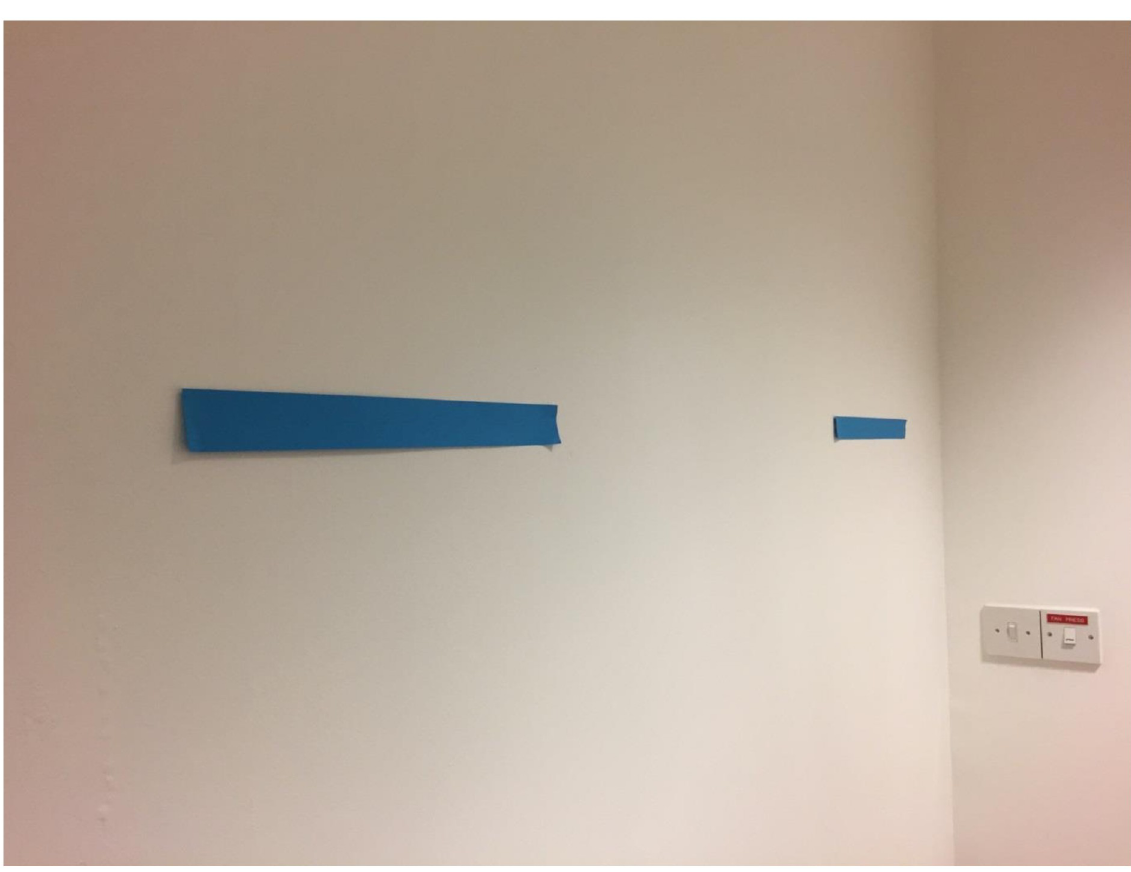
Fig 1. A photo of the lines on the wall from the participant’s location in the room. The two lines were of equal length but the closer line appeared longer. Note that the photograph is a faithful representation of the lines, i.e. we measured the lines in the photo and found that they corresponded to the real visual angle.